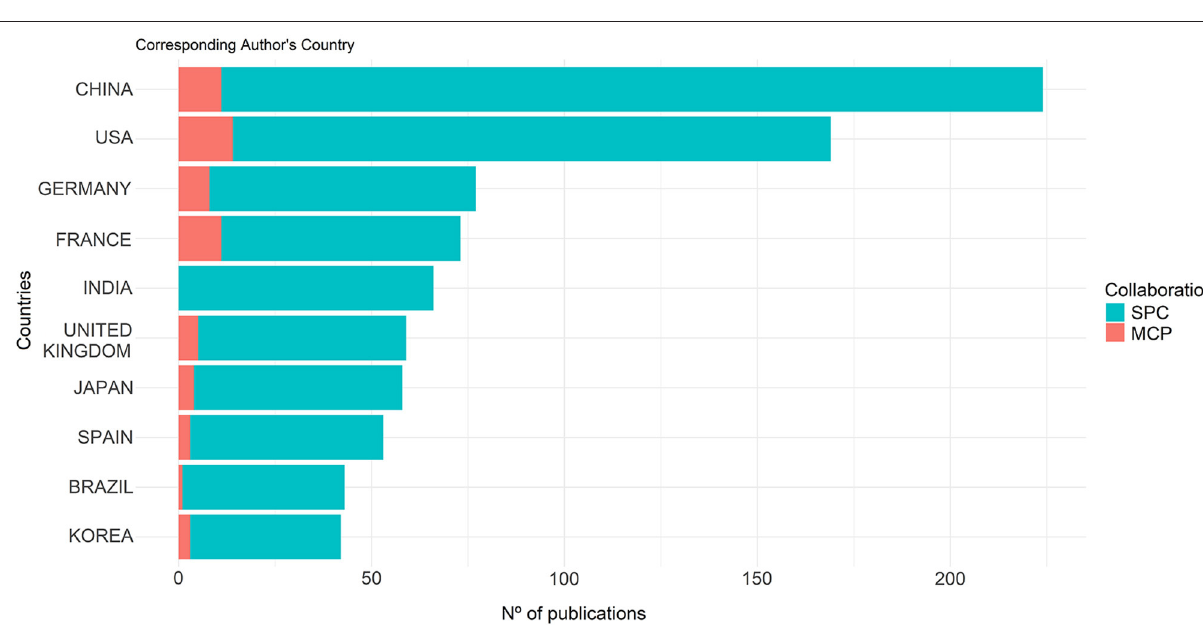
(21). The USA appeared twice on the rank occupying the 5th (University of Minnesota − 17) and the 9th (University of California − 15) positions. France represented Europe in the 3rd position (Centre National de la Recherche Scientifique – 19) and Italy in the 10th position (University of Naples Federico II − 15). No countries from Central and South America appeared on the rank, like Asia and